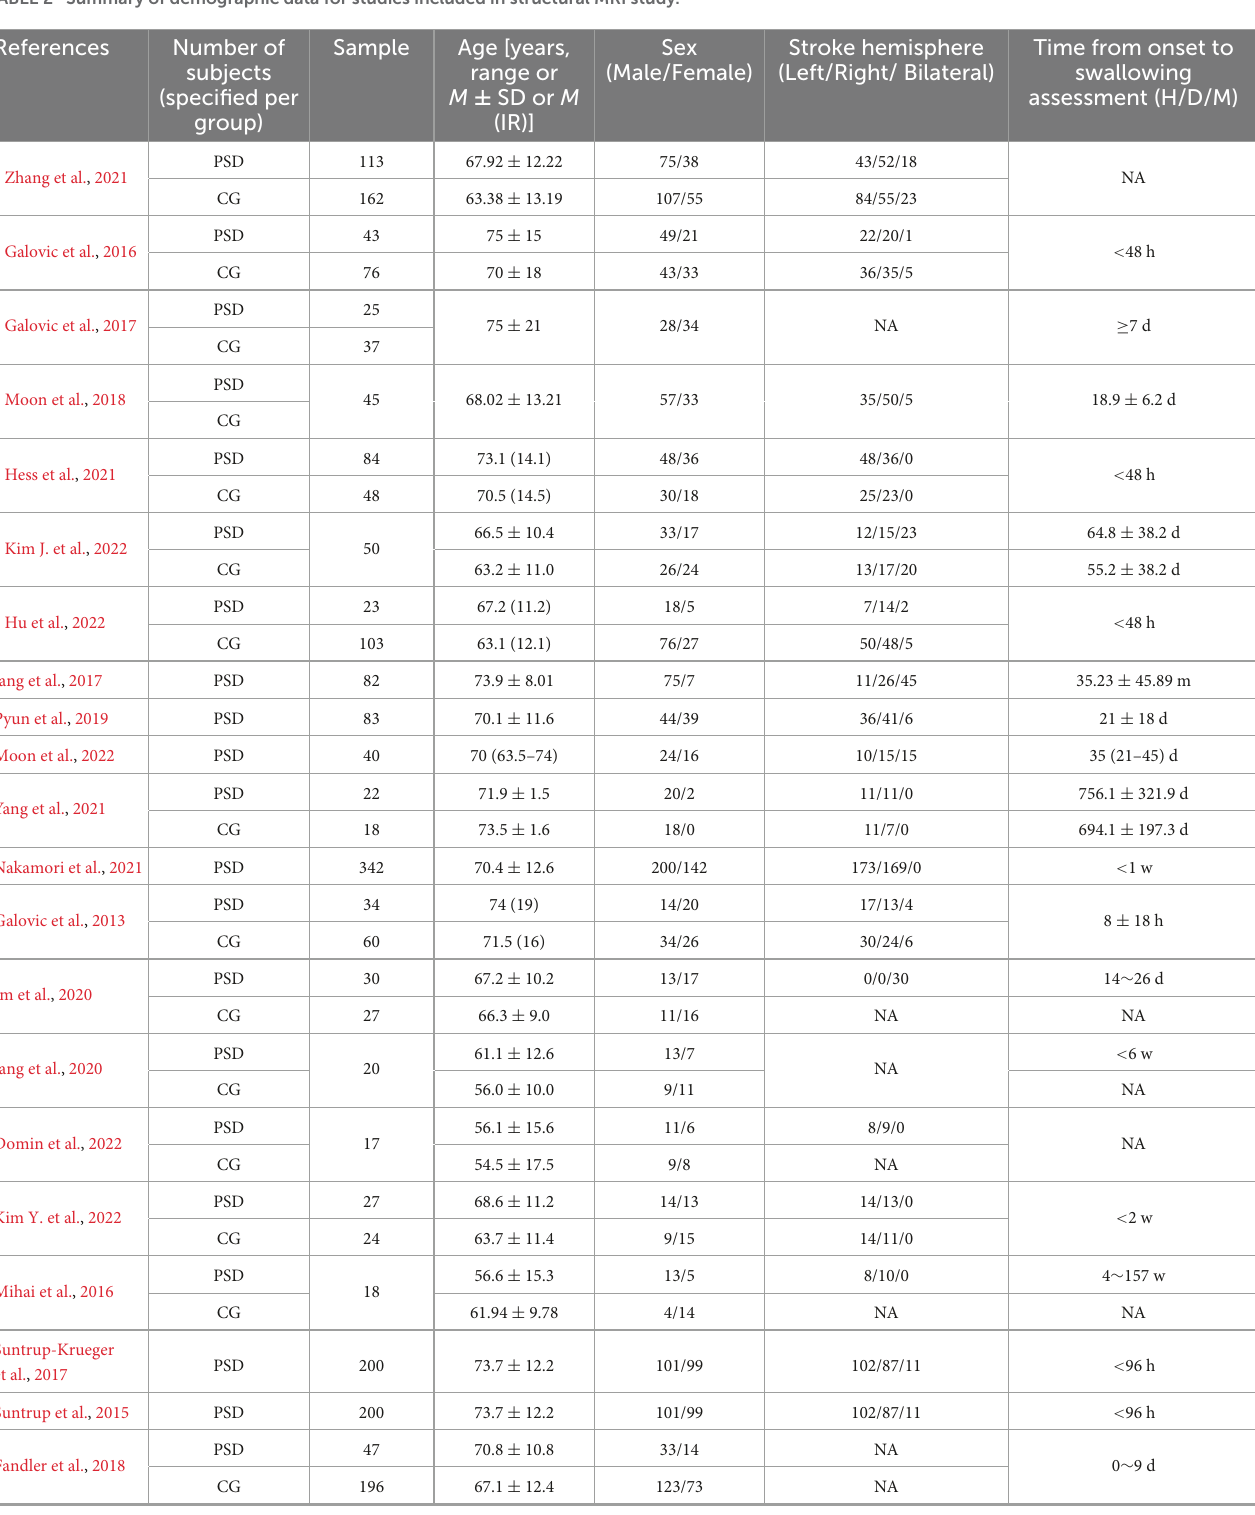
TABLE 2 Summary of demographic data for studies included in structural MRI